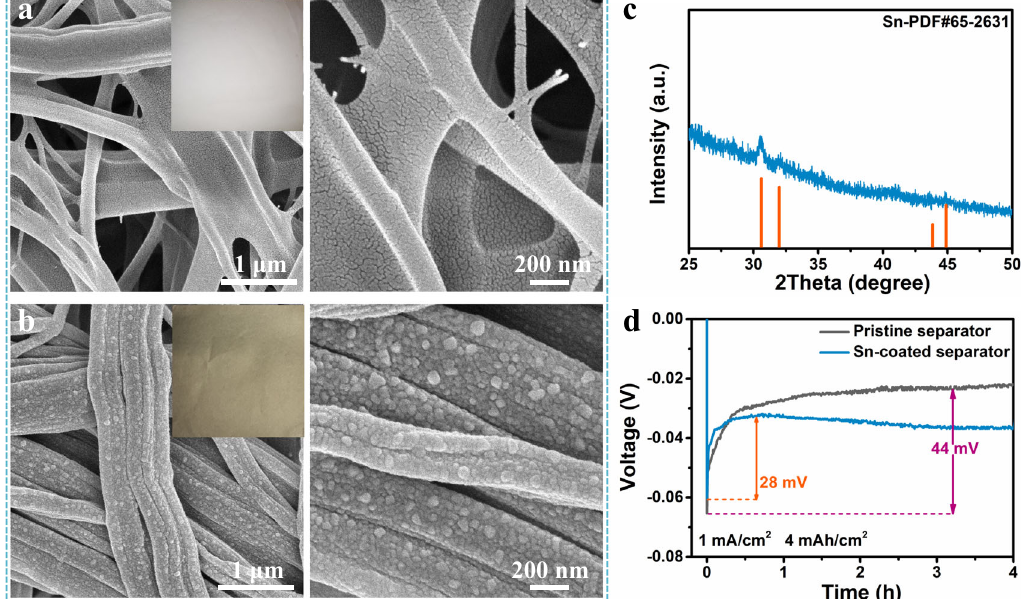
Fig. 3 Characterization of Sn-coated separator. The SEM images of a pristine separator and b Sn-coated separator with the corresponding optical photos in the insets. c The XRD spectrum of Sn-coated separator. d The nucleation overpotential of Ti/Zn cell with pristine separator and Sn-coated